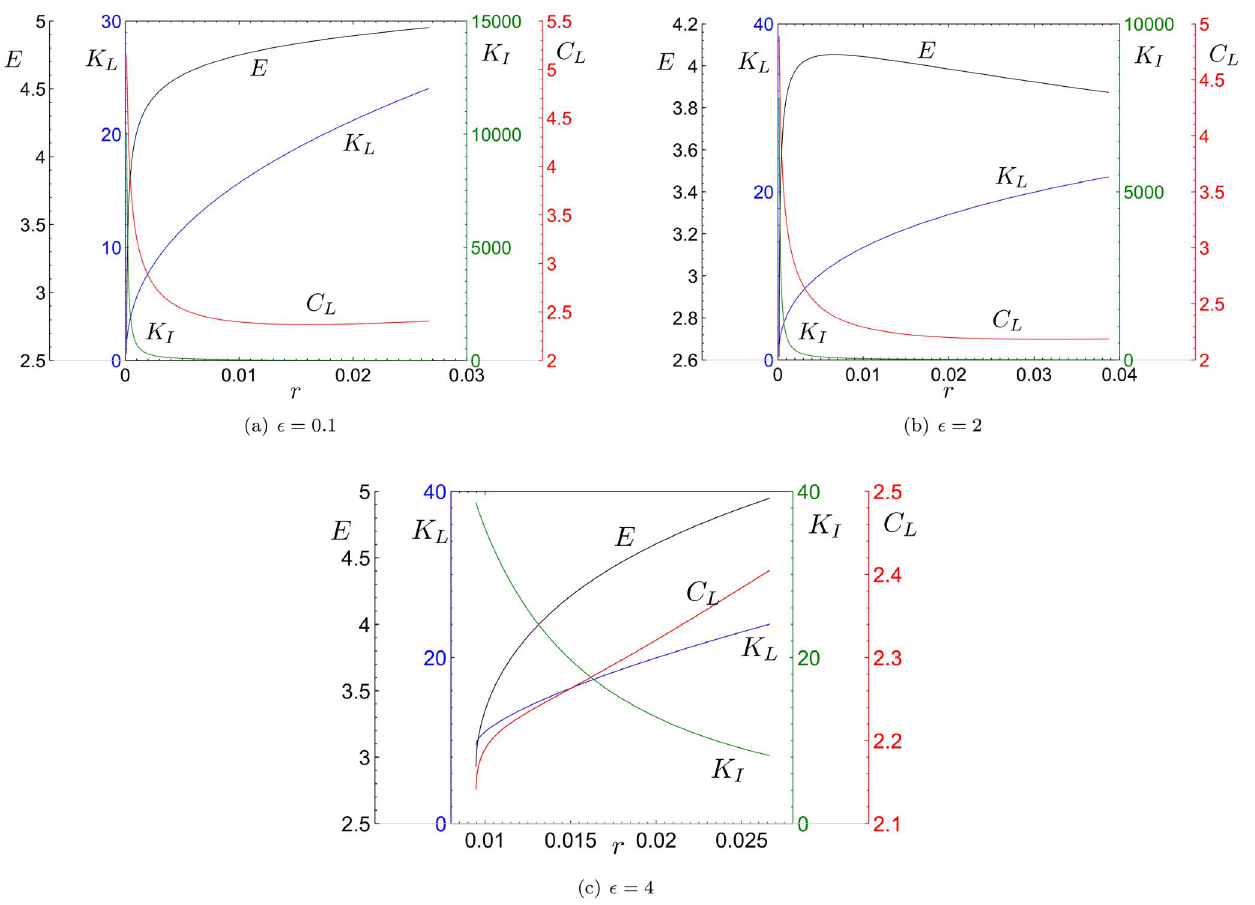
Fig. 4. Values of K (cid:2) ª ~ 0 : 2 , d ~ 0 : 01 , E ~ 5